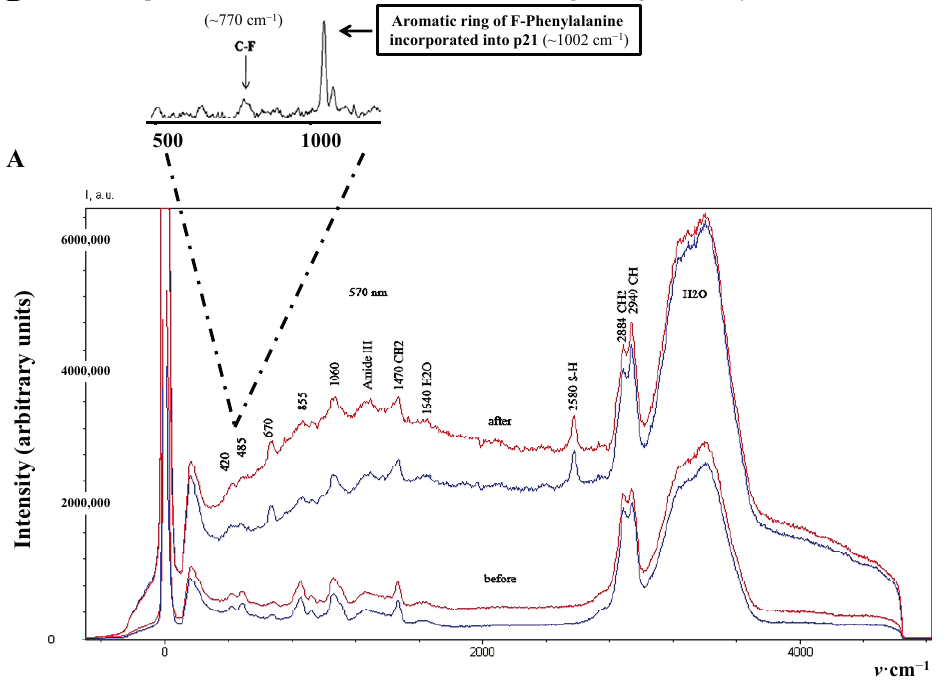
Figure 4. Spectro-Fluor™ spectra of the purified and enriched protein of interest. ( A ) Spectra in RIPA buffer of immune-precipitated p21 protein forms “before” (Time 0) and after (Time 24 h) effective incorporation of F-Phe (red spectrum) or non-labeled Phe (blue spectrum). 10 mg/mL of either amino-acid was added into McCoy’s 5a medium-containing HCT-116 colon cancer cells. ( B ) The F-p21 protein detection was performed after several washes with PBS 1X to significantly reduce the background generated by the RIPA buffer. The C-F signal is detected around 770 cm − 1 and the aromatic bond optical assignment of the incorporated phenylalanine is expectedly observed at 1002 cm − 1 . zoom after elimination fluorescence background generated by RIPA